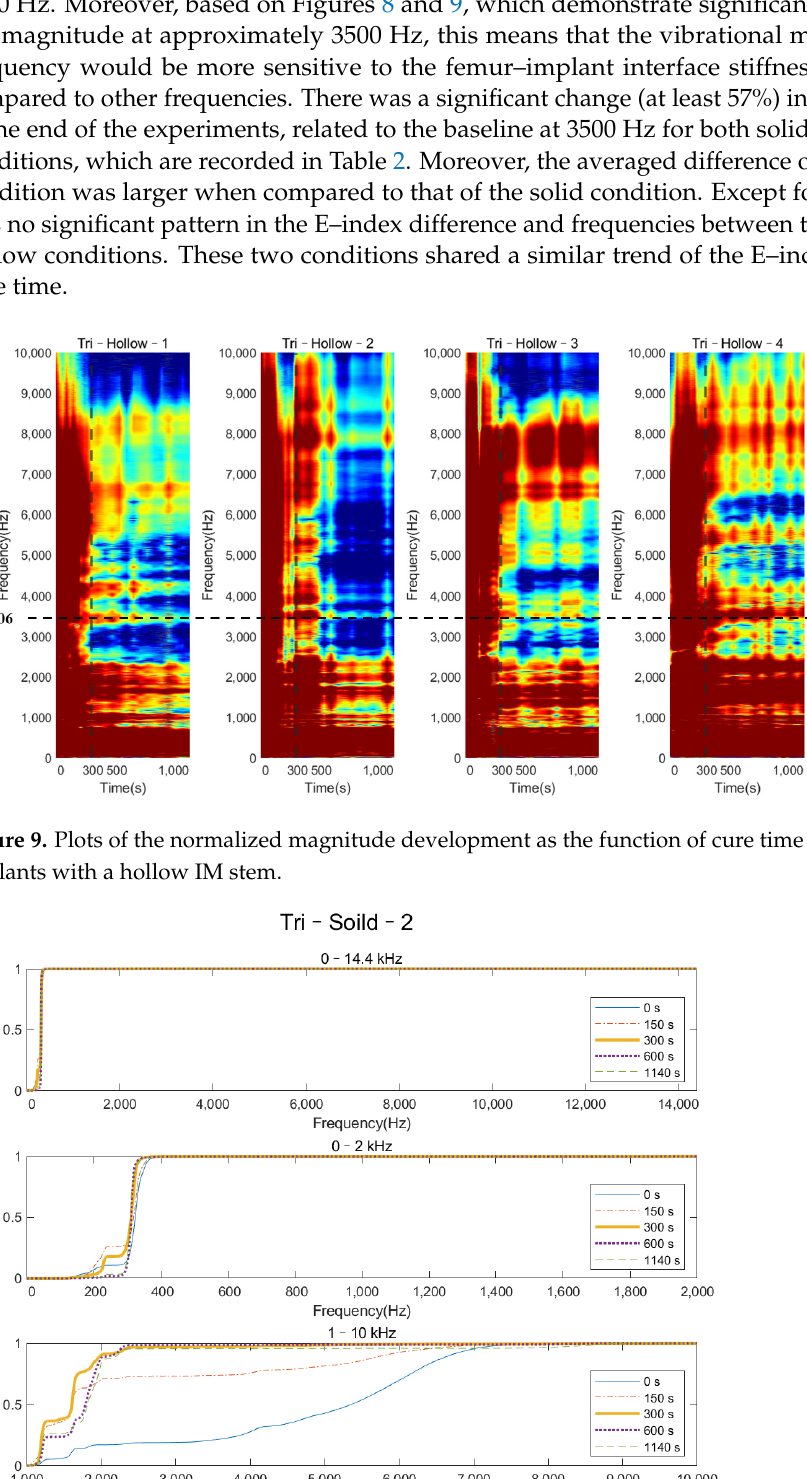
Figure 10. Plots of the E–index of triangular implants with a solid IM stem at five different times (0, 150, 300, 600, and 1140 s) for frequency ranges of 0–14.4 kHz, 0–2 kHz, and 1–10 kHz.